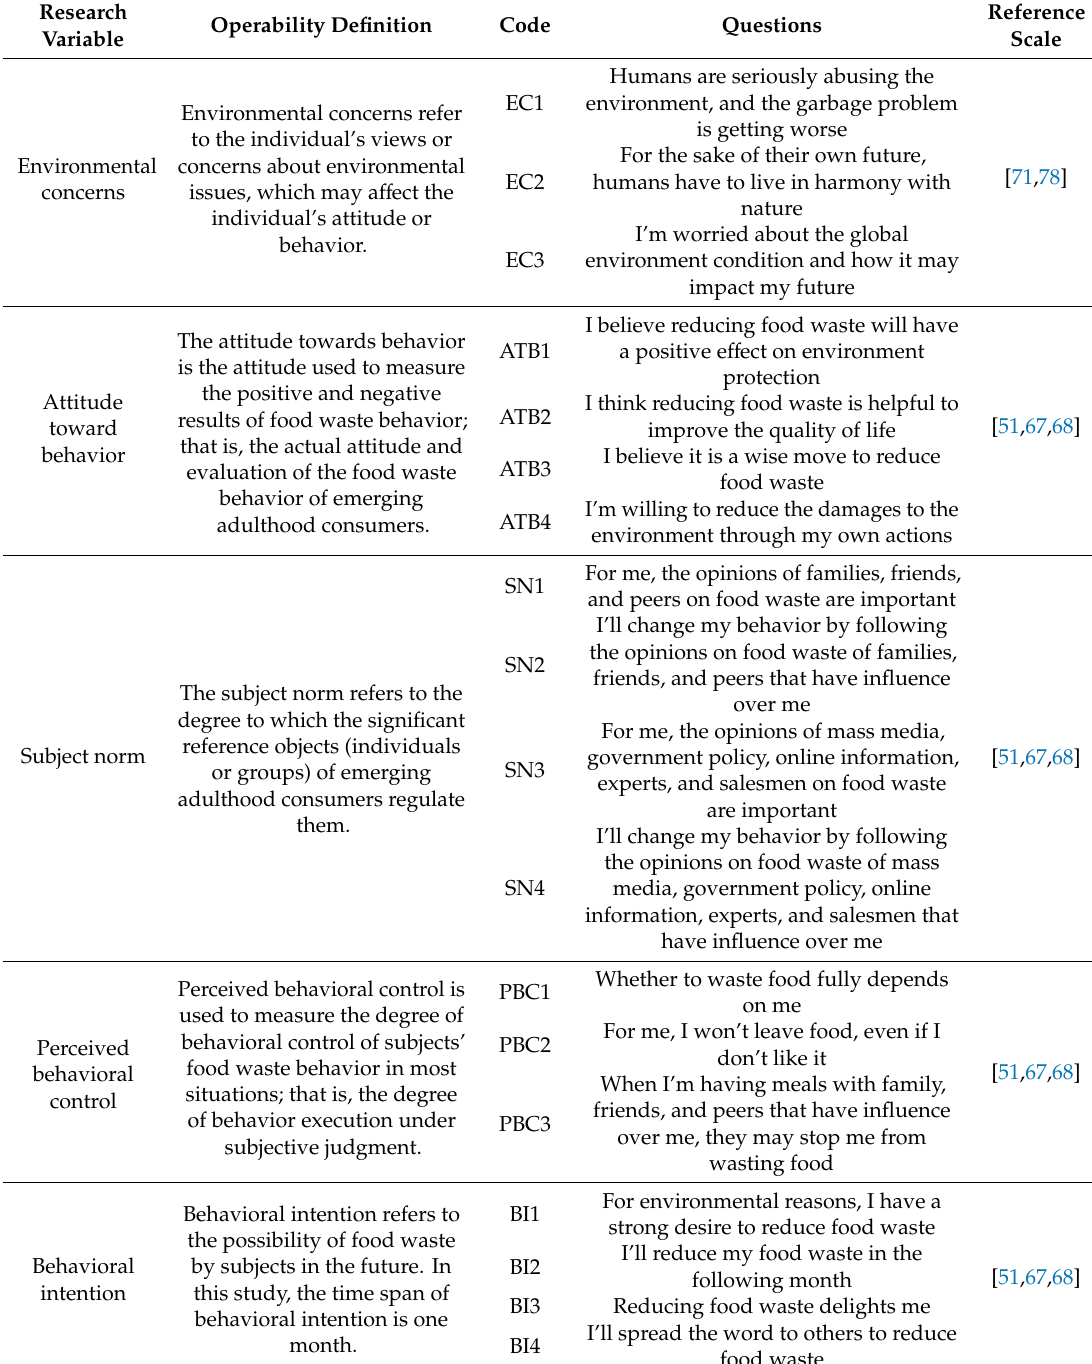
Table 1. Definition of variable operability and reference